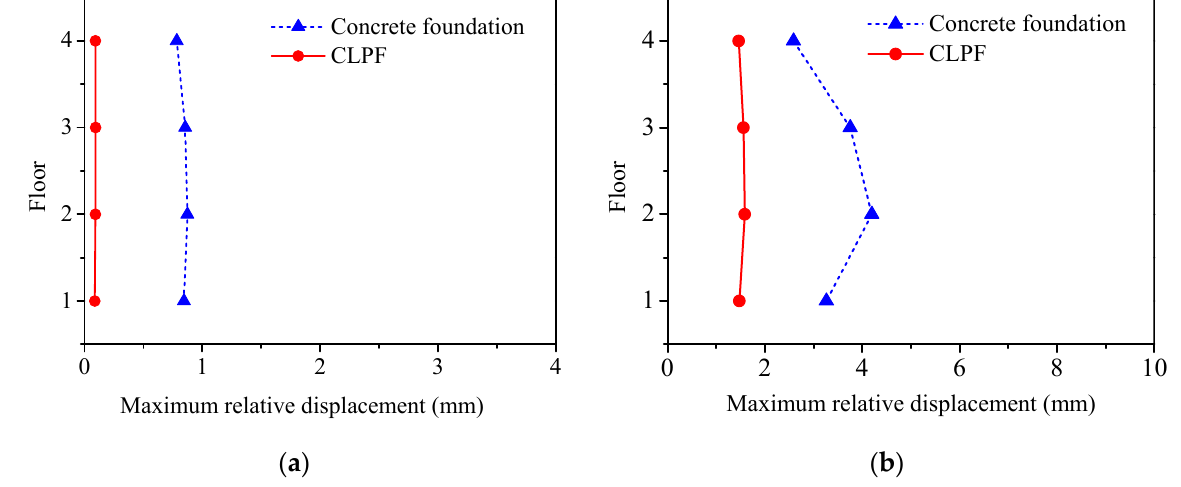
Figure 20. Maximum relative displacement of superstructure under: ( a ) the Whittier Narrows–02; and ( b ) the Oroville–01 seismic waves.